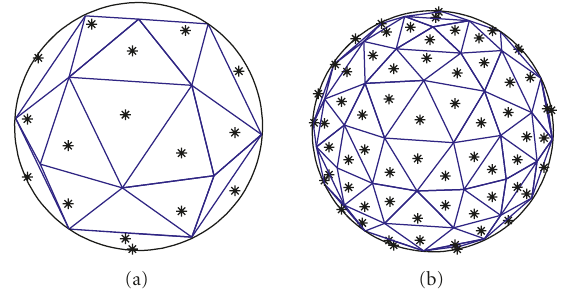
Figure 3: Distribution of target points over the unit-sphere, ob- tained by subdividing an octahedron once (left: 32 points) and twice (right: 128